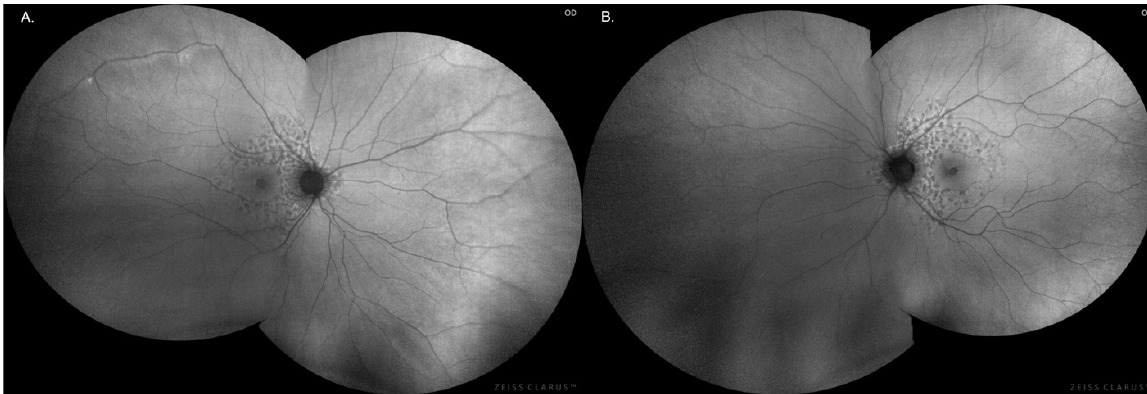
Figure 4. Autofluorescence of the fundus of the right eye ( A ) and left eye ( B ), respectively, with characteristic RPE lesions located centrally and in the middle periphery of the retina, visualized with the characteristic reticular pattern.